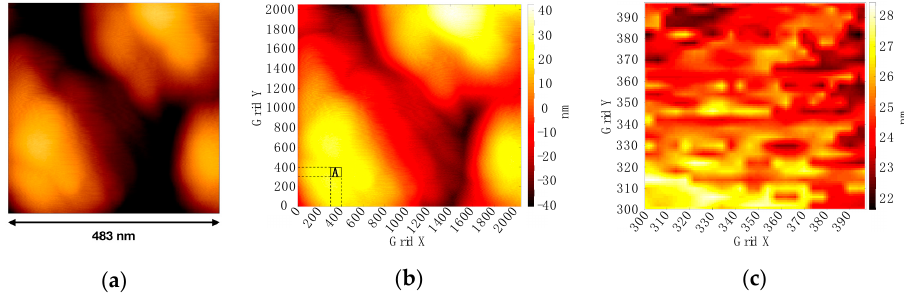
Figure 1. ( a ) 512 × 512 pixel AFM scan of the Ketton carbonate sample with a pixel size of 0.943 nm; ( b ) shows a heatmap of the scan ( a ) interpolated twice into 2048 × 2048 grid cells or interpolated pixels, each grid cell has a side length of 0.236 nm; ( c ) is a zoomed version of region A. Region A contains 96 × 96 interpolated pixels, translating to an area of 22.656 nm × 22.656 nm. The color bar represents the elevation in nm in the z -axis.